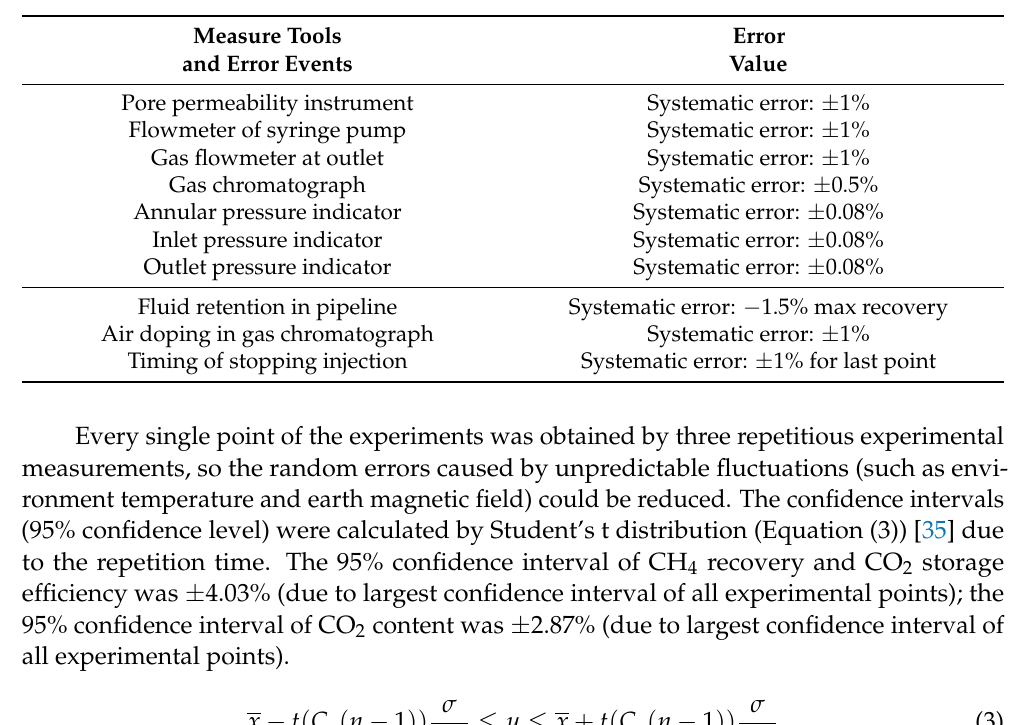
Table 6. Measure tools and systematic error